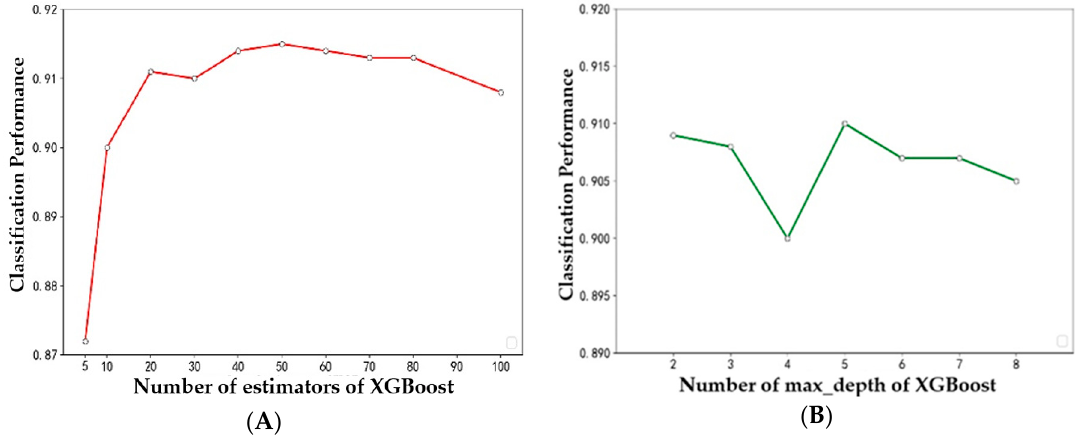
Figure 7. Classification performance of different ( A ) number of evaluators and ( B ) depths for XGBoost.